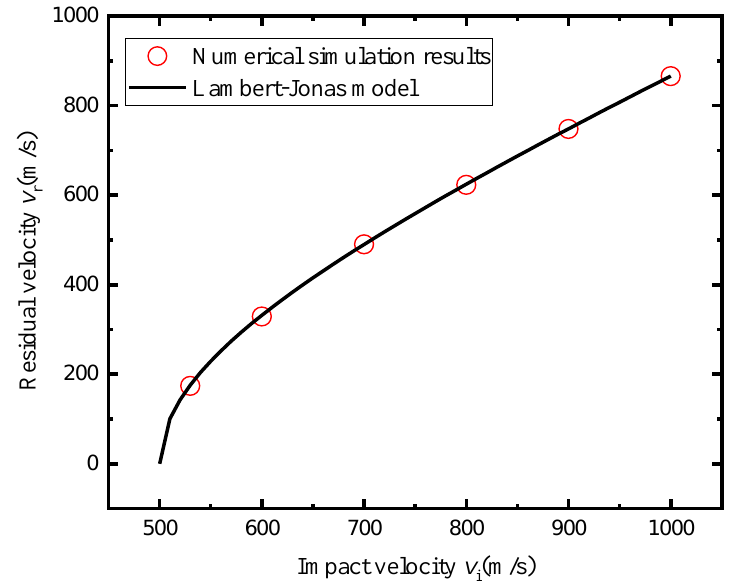
Figure 12. Comparison between the Lambert – Jonas model and the numerical simulations.